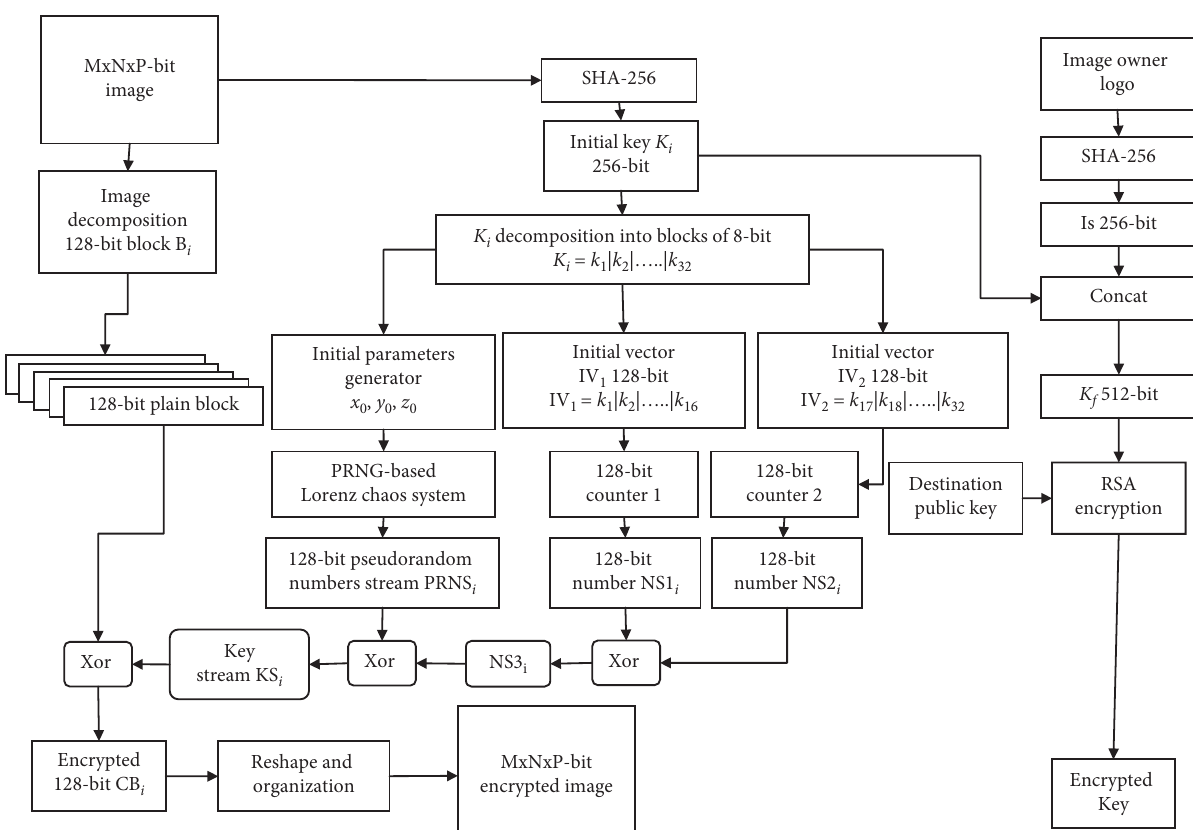
Figure 2: Flowchart of the proposed encryption system.